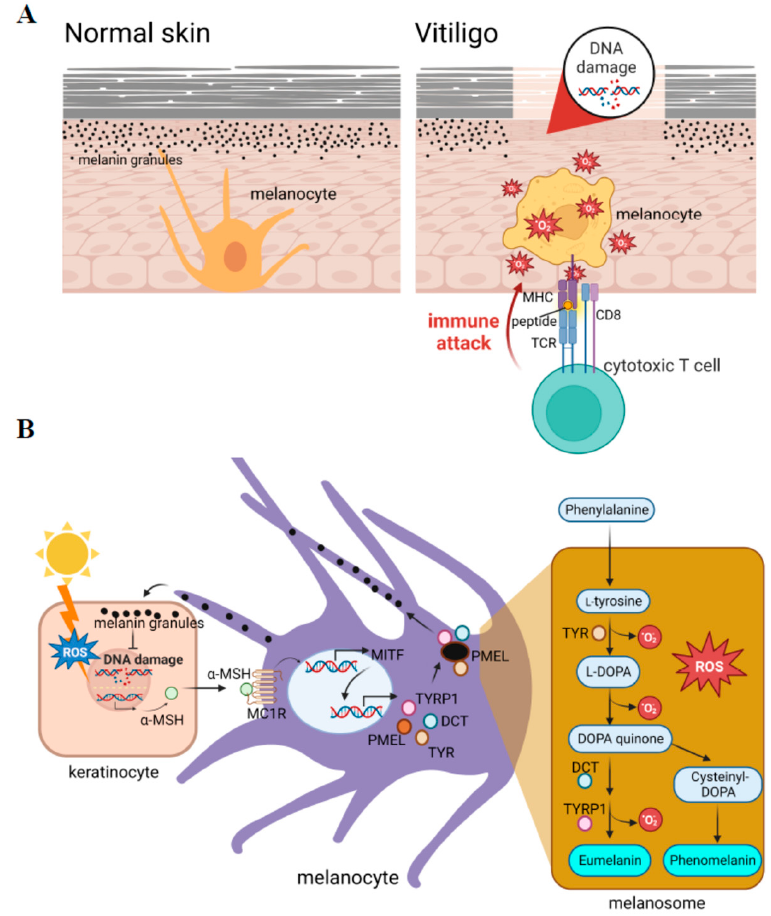
Figure 1. Reactive oxygen species (ROS) play crucial roles in the initiation of vitiligo. ( A ) Vitiligo is a depigmentation skin disorder caused by dysfunctional melanocytes that are attacked by immune cells. ( B ) Melanogenesis generates intracellular ROS. The production of melanin is activated by exposure to sunlight, which leads to the production of the ligand for activation of the transcription of microphthalmia-associated transcription factor (MITF) in melanocytes. MITF activates a series of pigment-specific enzyme genes including TYR (tyrosinase), DCT (dopachrome tautomerase), and TYRP1 (tyrosinase-related protein 1). The process of melanogenesis is shown in the right penal, in which a pro-oxidant state is generated during melanogenesis. α -MSH: alpha-melanocyte-stimulating hormone; PMEL: pre-melanosome protein; L-DOPA: 3,4-dihydroxy